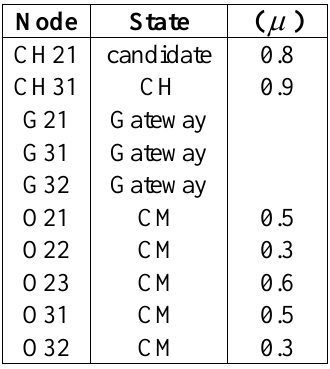
Table 2. Information for C2.